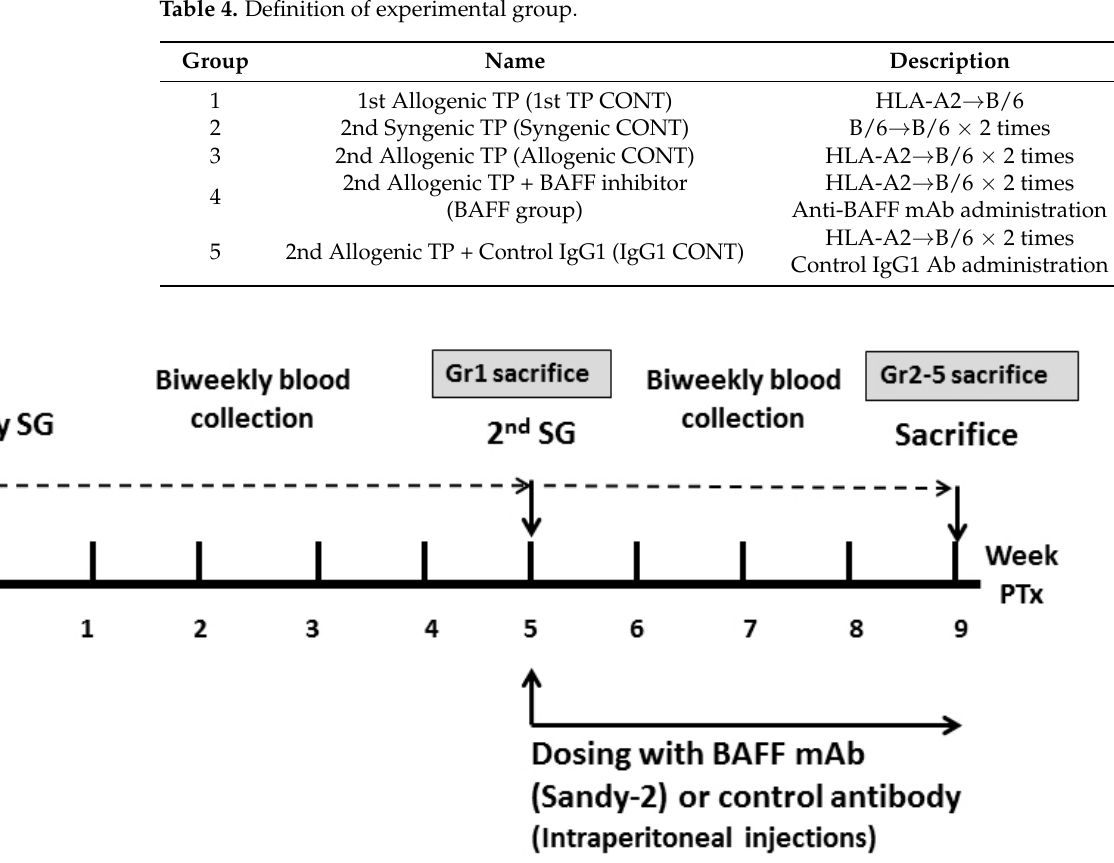
Figure 8. The Study Protocol. Abbreviations: SG, skin graft; Gr, group; PTx, post-transplant; BAFF, B cell activating factor; mAb, monoclonal antibody.